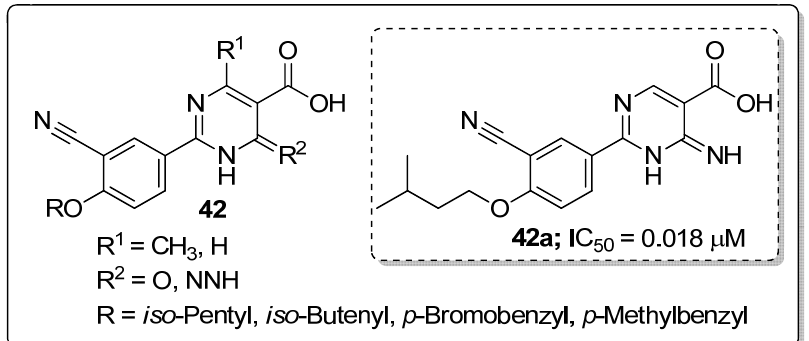
Figure 49. Xanthine oxidase (XO) inhibitory activity of the most active dihydropyrimidine-5-carboxylic acid analog 42a .